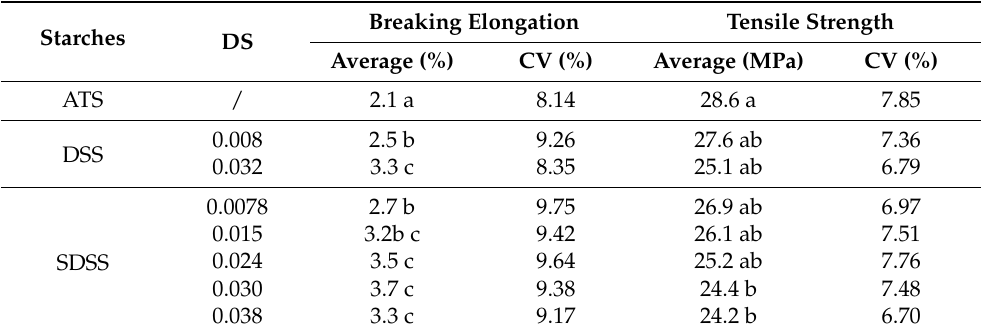
Table 2. Influence of sulfododecenylsuccination on tensile strength and breaking elongation of starch